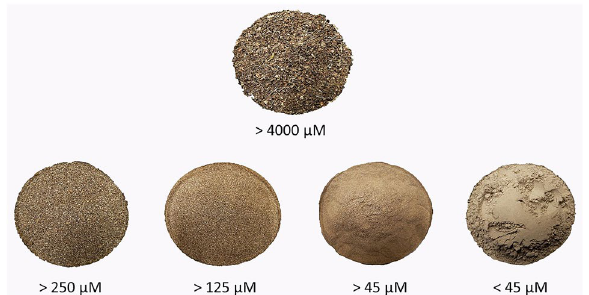
Figure 1. Brown macroalgae S.cristaefolium and their corresponding thallus grounded to different particle sizes.